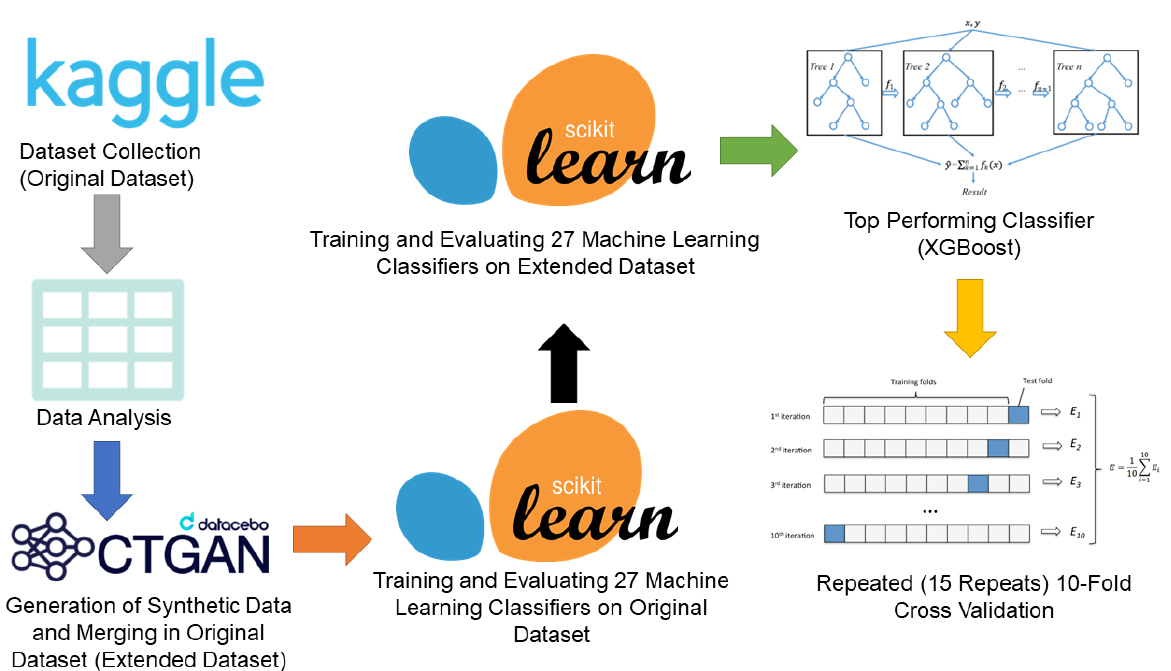
Figure 1. A graphical overview of the whole methodology.